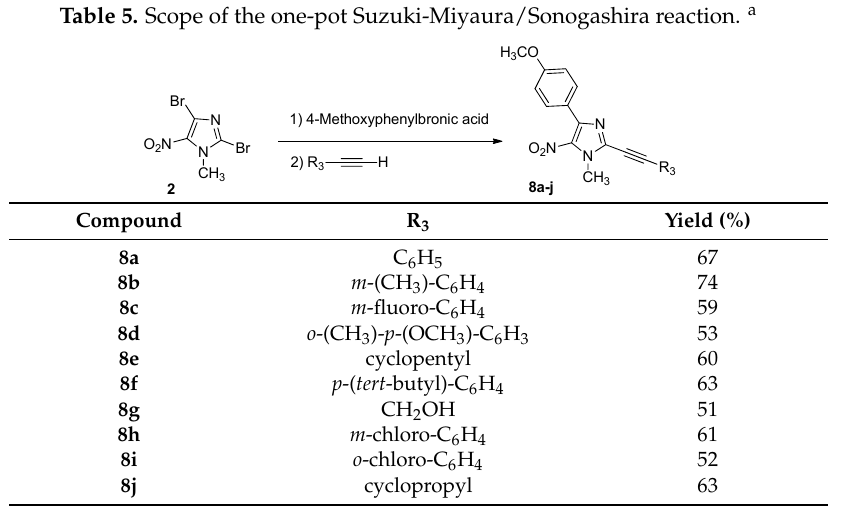
Table 5. Scope of the one-pot Suzuki-Miyaura/Sonogashira reaction. a